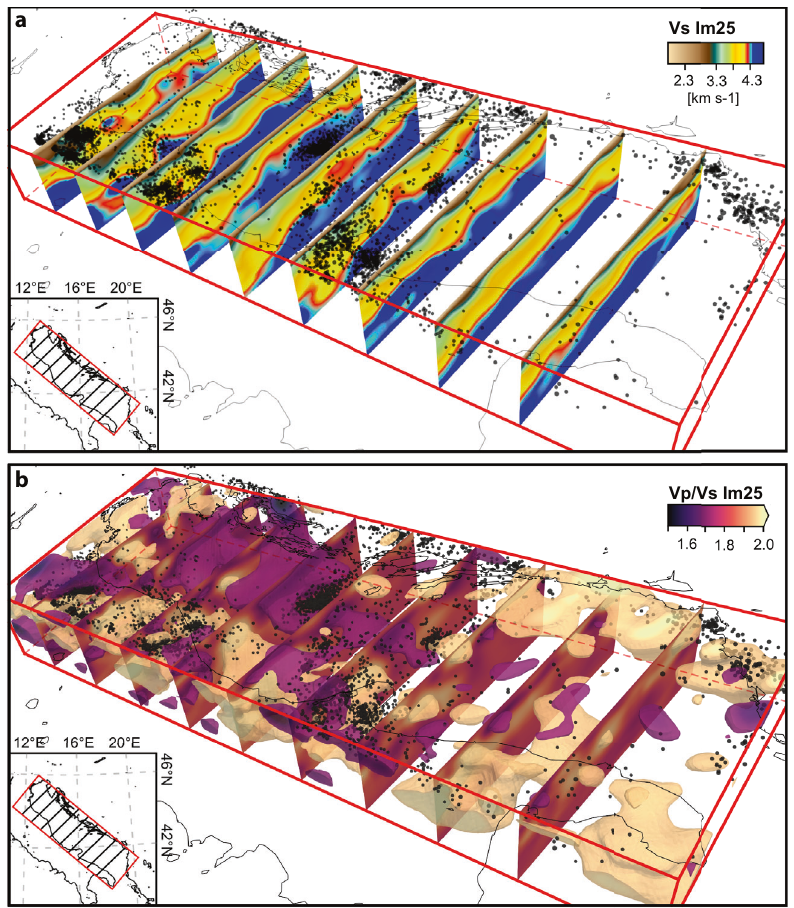
Fig. 4 Cross-sections through the Adriatic Sea for Im25 . The nine slices, visualized in 3D, are oriented SW-NE through the Adriatic plate and show model Im25 for V V V s ( a ) and p / s ( b ). Inset map shows cross-section locations. Black dots represent the seismicity with locations from the INGV bulletin 85 . The slices are 260 km long and 80 km deep; coastlines are plotted on top of the slices. In ( b ), the purple and yellow isovolumes correspond to V p / V s values of 1.7 and